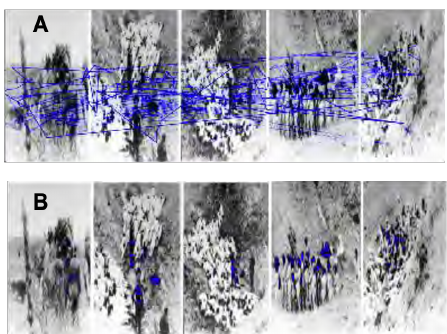
Figure 7. Clustering result on the trajectories of all the par- ticipants. The segments show the densest parts of trajectories. In orange, we find the densest segments but which, in addition, experience strong saccades.